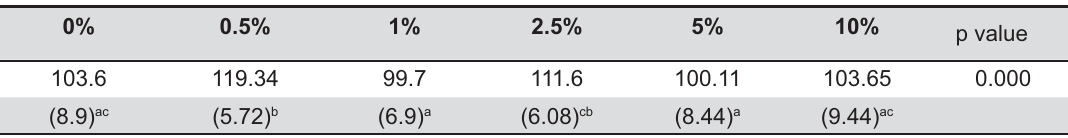
Table 3- Mean standard deviation (SD) of compressive strength of self-cured acrylic resin incorporated with different percentages of nanostructured silver vanadate